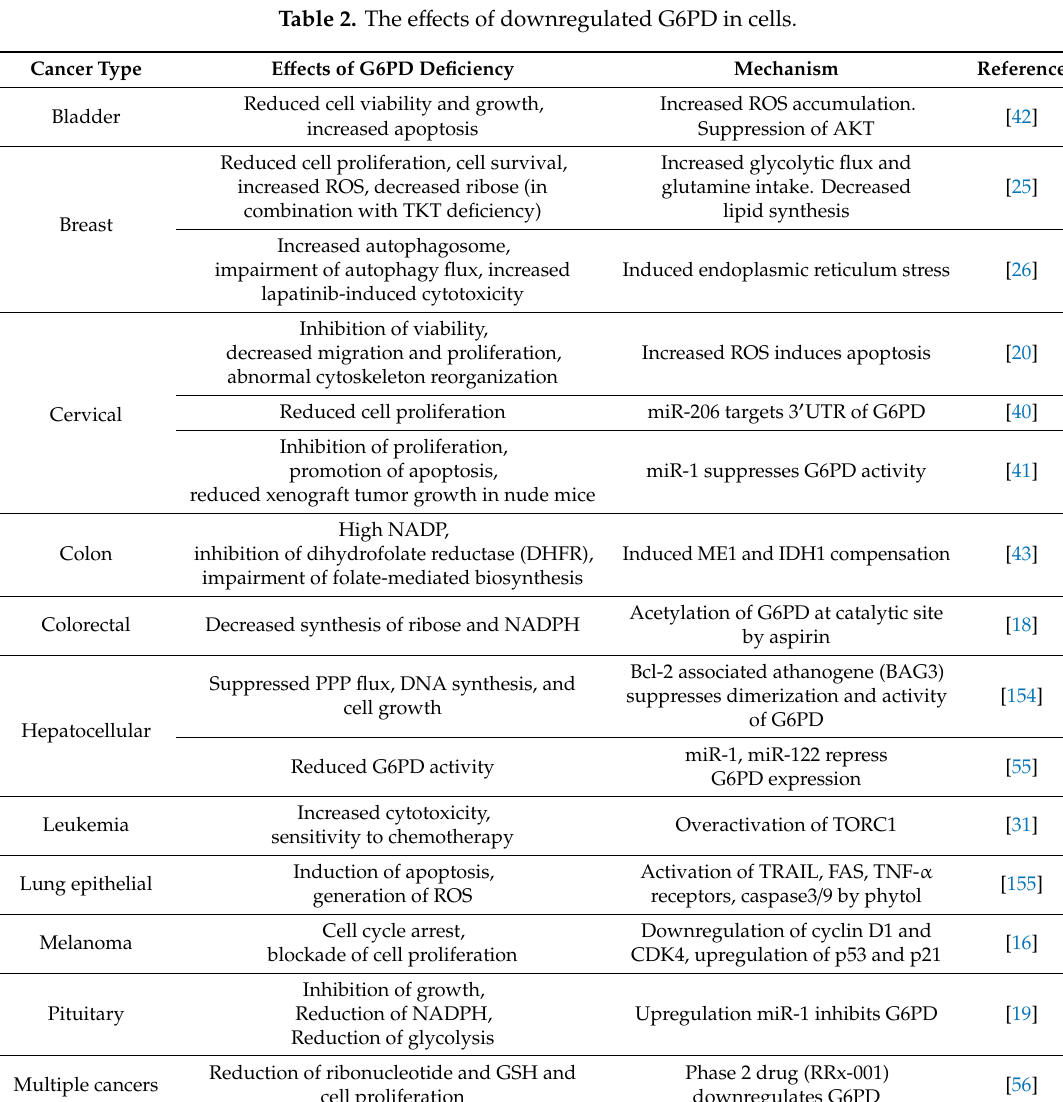
Table 2. The e ff ects of downregulated G6PD in